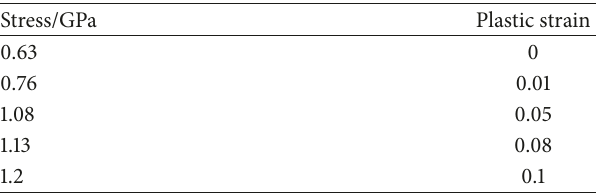
Table 2: Plastic behavior of SCM35 alloy steel.